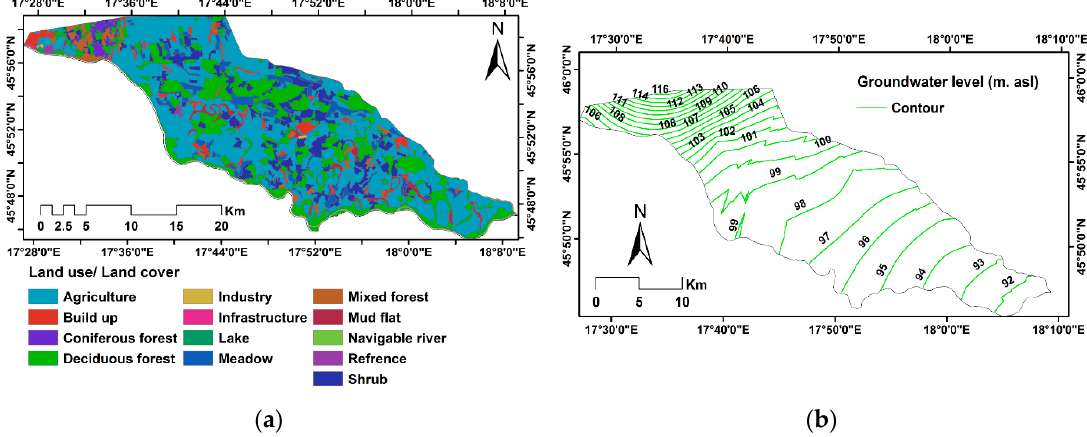
Figure 3. ( a ) Land use classes of the Drava floodplain, ( b ) contour line of the average depth to groundwater level.